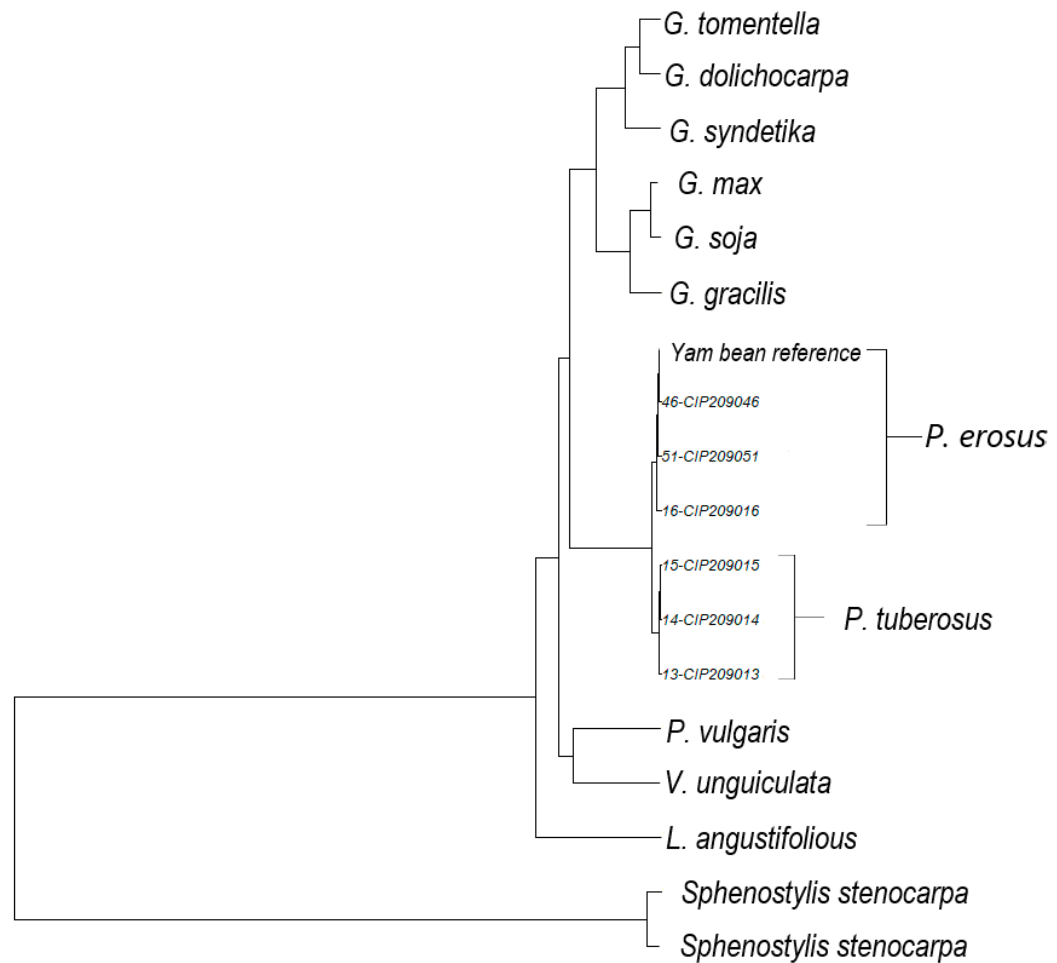
Figure 3. A Mash rooted phylogeny tree displaying assorted members from the Glycine family and other related legumes. The closest relative to either species of yam bean ( Pachyrhizus erosus or Pachyrhizus tuberosus ) is Glycine max , Glycine soja and Glycine gracilis.